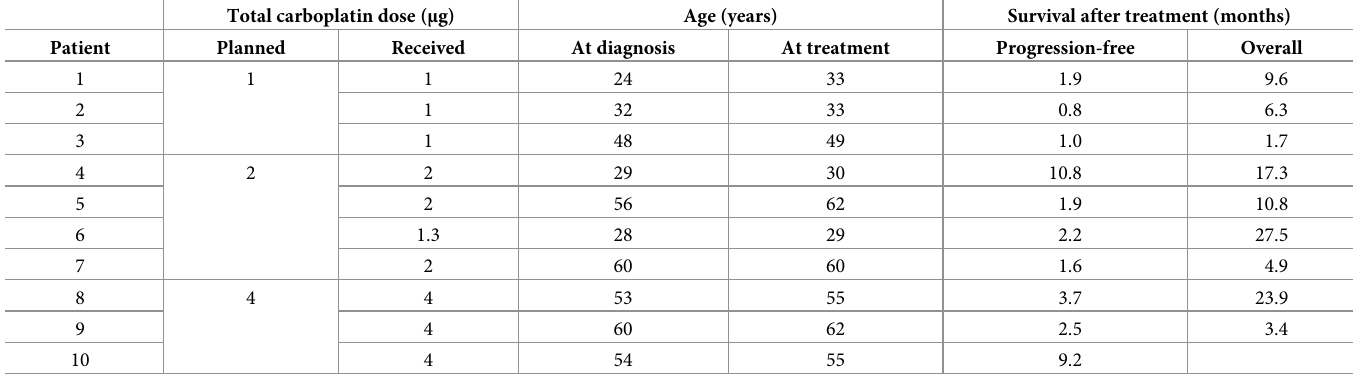
Table 3. Patient survival